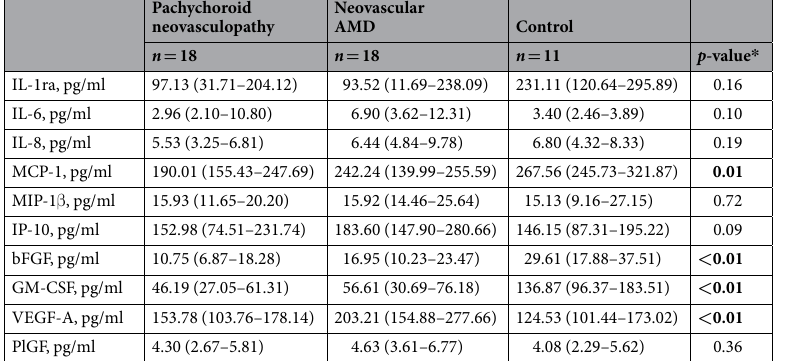
Table 2. Levels of Ten Cytokines in the AH among the Three Groups. Values are the median (interquartile range). P < 0.05 was considered significant (bold). * Kruskal-Wallis test. AMD = age-related macular degeneration; IL-1ra = interleukin 1 receptor antagonist; IL = interleukin; MCP-1 = monocyte chemoattractant protein 1; MIP-1 β = macrophage inflammatory protein 1 β ; IP-10 = interferon- γ -induced protein 10; bFGF = basic fibroblast growth factor; GM-CSF = granulocyte macrophage colony-stimulating factor; VEGF-A = vascular endothelial growth factor A; PlGF = placental growth factor. Other cytokines were below the detection limit.